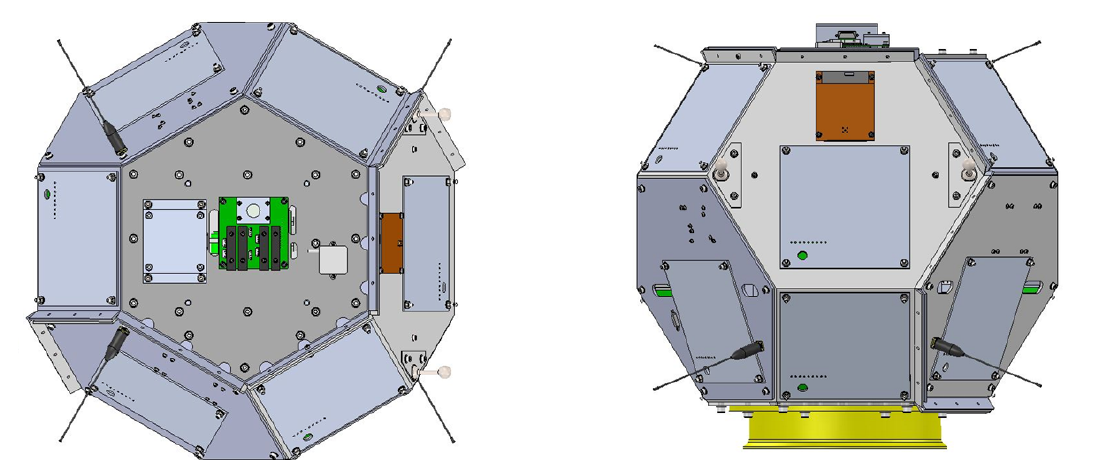
Figure 5. Two orientation scenarios of Ten-Koh satellite: ( Left ) worst-case scenario for power generation because the least area is exposed to solar radiation; and ( Right ) best case for power generation. The launcher adapter ring is shown in yellow.